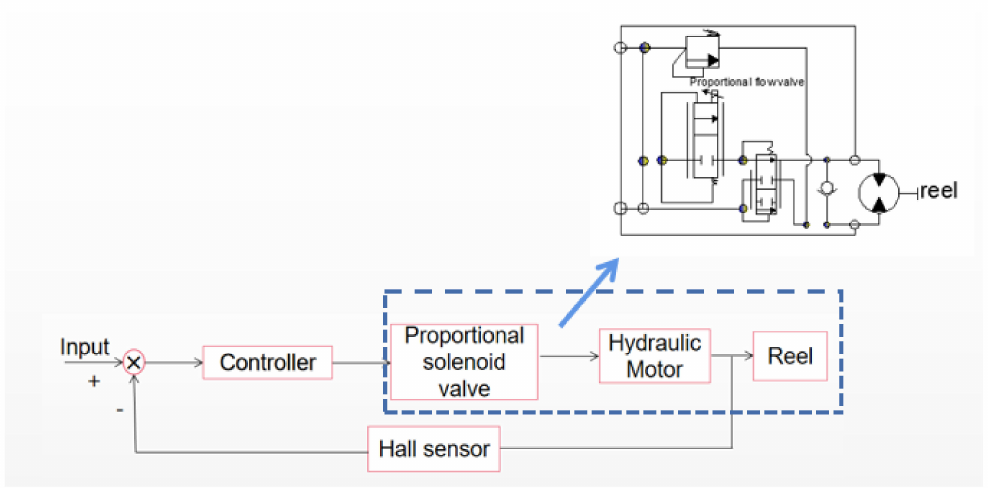
Figure 10. Proportional solenoid valve drive hydraulic motor schematic